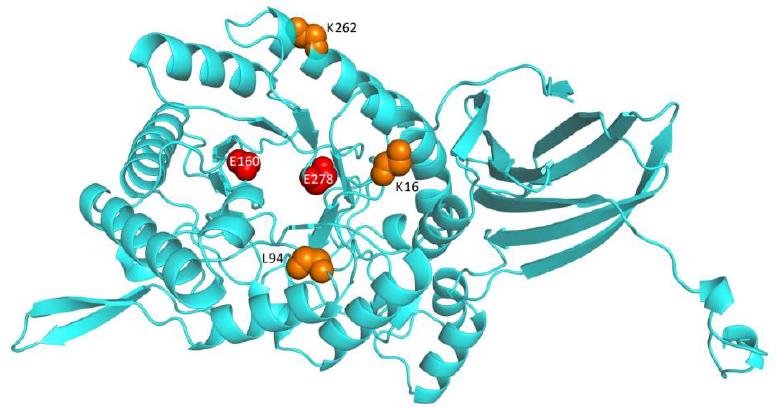
Figure 7. The protein structures of wild type xylosidase Xyl21. Two conserved catalytic residues (Glu160 and Glu278) are marked in red, and three mutated sites (K16, L94, and K262) are displayed in orange.